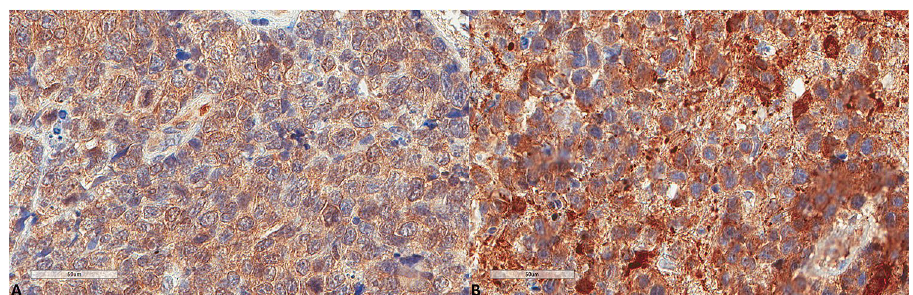
Figure 3. Representative images of LC3B expression. ( A ) Lower expression in a patient diagnosed with PCNSL MSKCC B group (× 400). ( B ) Higher expression in a patient diagnosed with PCNSL MSKCC C group (× 400).